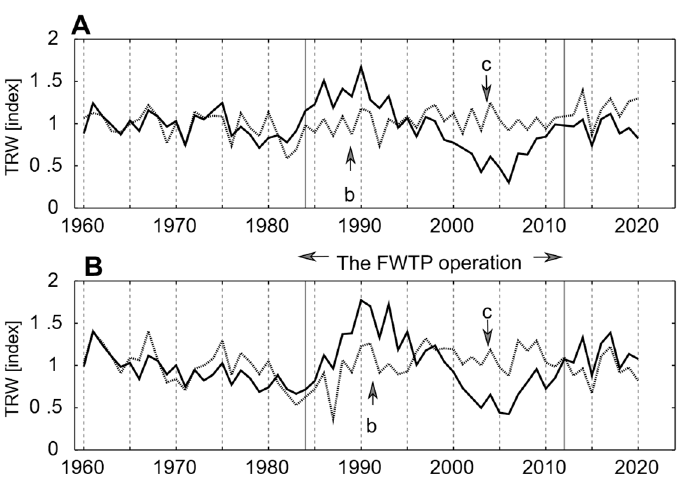
Figure 5. Comparison of standard chronologies of Scots pine from study plots. ( A )–plots with younger trees (P1, P1 control); ( B )–plots with older trees (P2, P2 control). Black lines–chronology for P1 and P2, respectively, dashed grey lines–chronology for control plots, P1 control and P2 control, respectively. The vertical lines indicate the period of operation of the Forest Wastewater Treatment Plant [FWTP]; the letters marked: b–the first decade of sprinkling with sewage of stands; c– subsequent years of the fertilization with sewage.